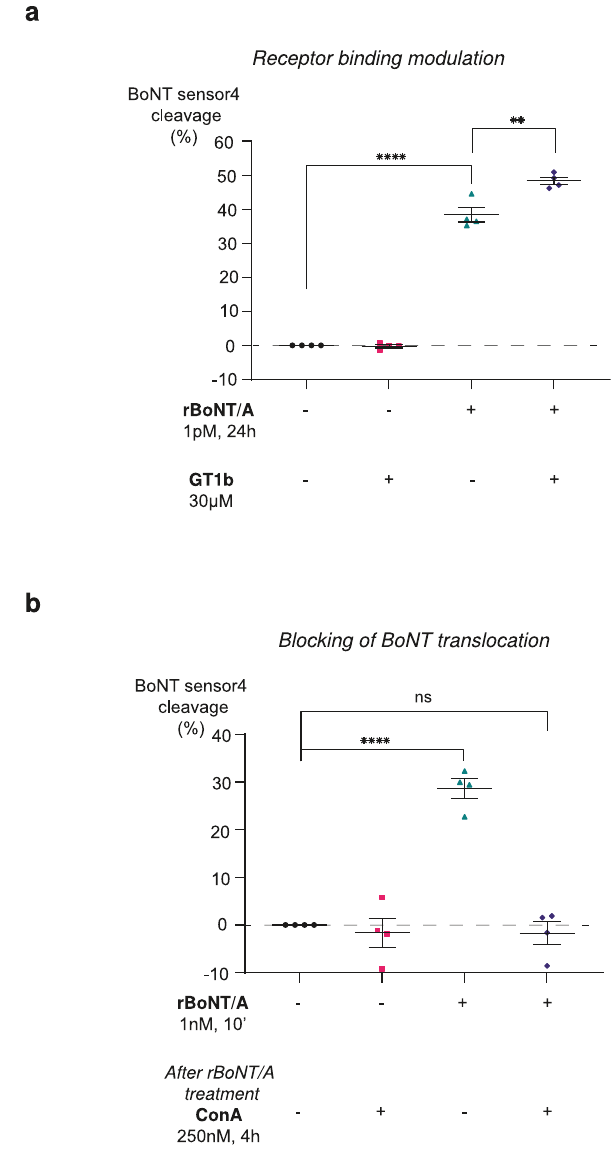
Fig. 4 Mechanistic assay using the CB-assay. a Increasing cell uptake by GT1b addition. rBoNT/A (1 pM) was incubated 24 h in the absence (green triangles) or presence of GT1b (blue diamonds) and the action of the toxin was determined by measuring the percentage of BoNT sensor4 cleavage. Data points are plotted as individual values for each independent experiment and mean (4 experiments performed in triplicates). Controls are cells with no treatment corresponding to basal conditions (black circles) and cells incubate only with GT1b (pink squares). b Blocking of toxin action by ConA. rBoNT/A (1 nM) was incubated 10 min in stimulating conditions (60 nM KCl). After toxin washout and 4 h in the absence (green triangles) or presence (blue diamonds) of ConA, the percentage of BoNT sensor4 cleavage was determined. Data points are plotted as individual values for each independent experiment and mean (4 experiments performed in triplicates). Controls are cells with no treatment corresponding to basal conditions (black circles) and cells incubate only with ConA (pink squares). Data points are mean of n = 4 independent experiments in triplicate. Statistical ordinary one-way ANOVA multiple comparisons: * P < 0.05; ** P < 0.01; *** P < 0.001; **** P < 0.0001; NS, P > 0.05 not signi fi cant (NS). Error bars show